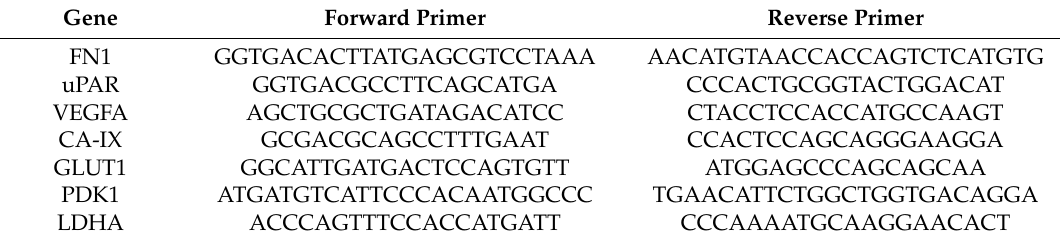
Table 1. Primer sequences for quantitative real